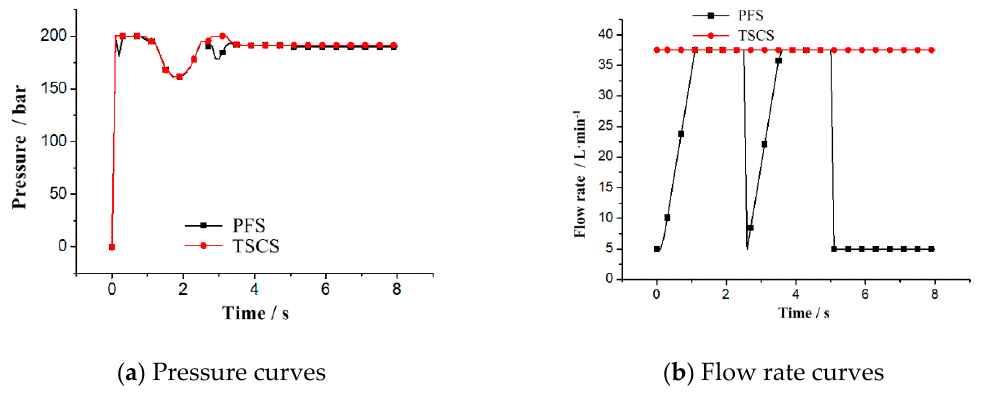
Figure 10. Pressure and flow rate curves of the pump outlet of the two systems.